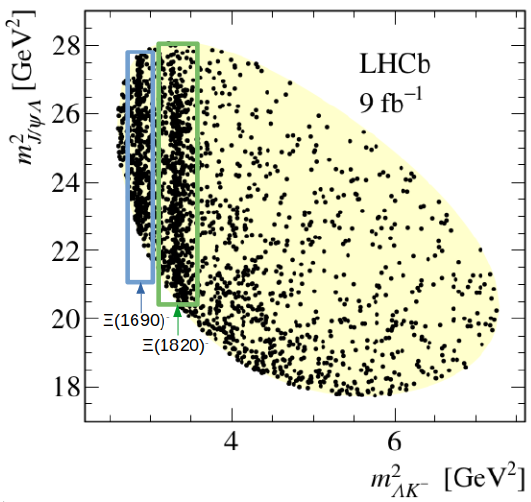
Figure 4: The squared mass of the Λ K − is plotted against the squared mass of the J /ψ Λ . Two vertical bands are highlighted which correspond to resonances from two different Ξ states.